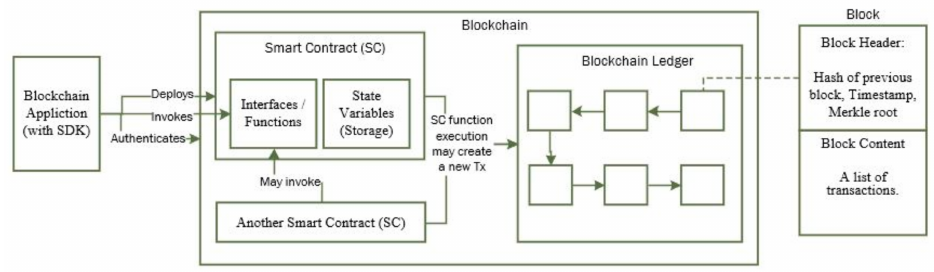
Figure 5. Interaction between application, smart contract and